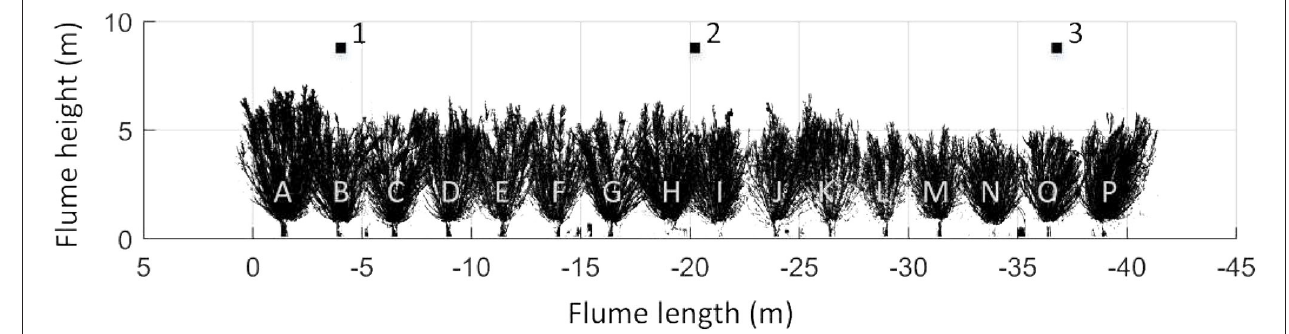
FIGURE 5 | Side view of the 3D-point cloud of the entire forest without leaves. The tree names (A-P) and the laser scanner positions (1-3) are illustrated.